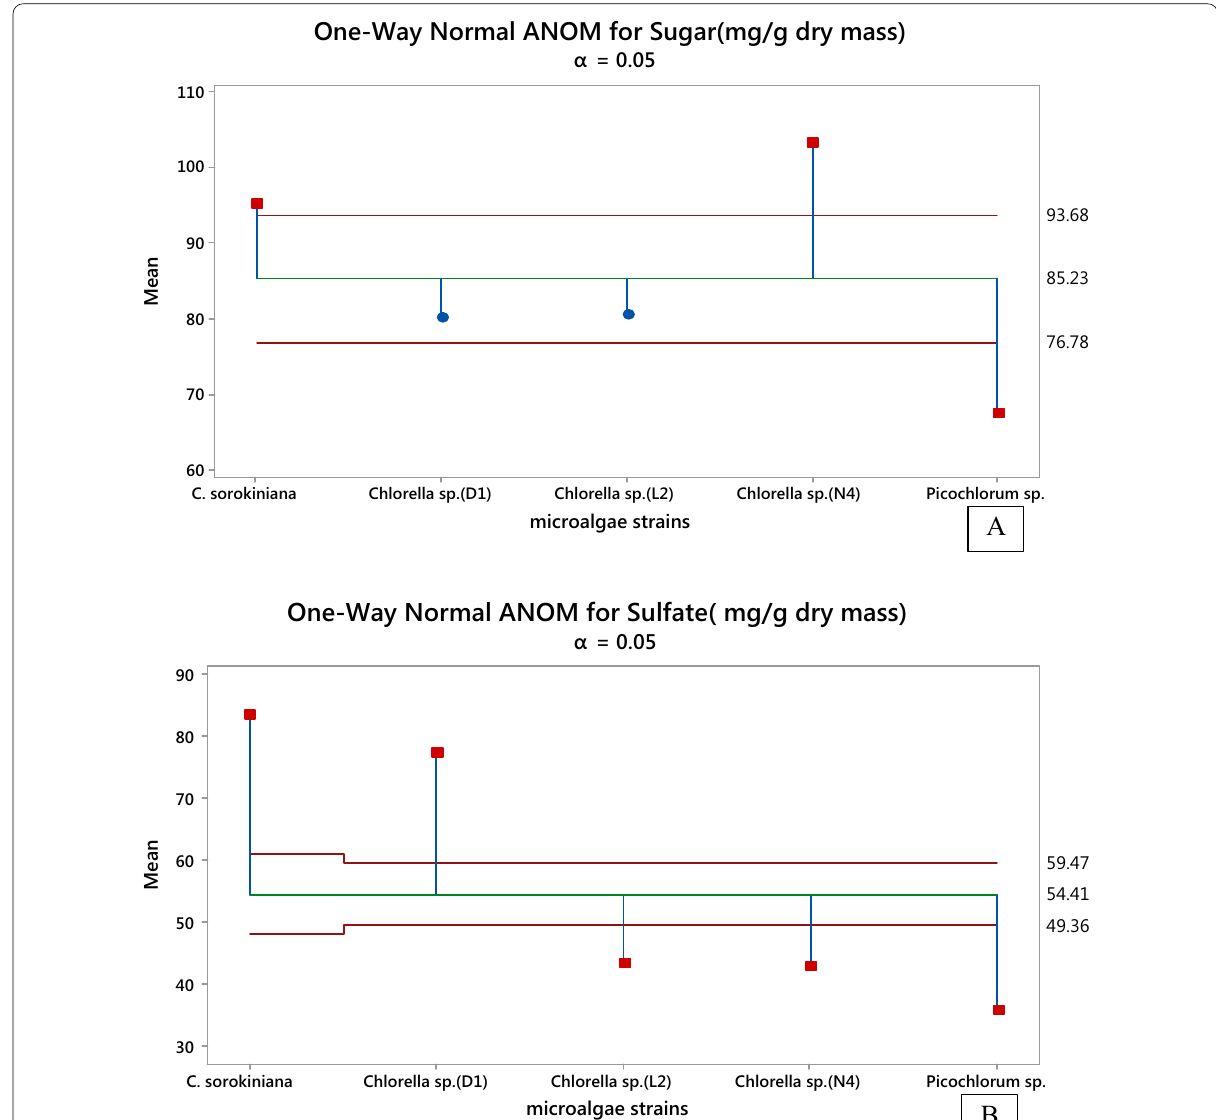
Fig. 3 One-way normal Analysis of Mean (ANOM) for A sugar and B sulfate (mg/g dry biomass) in different strains (Alpha